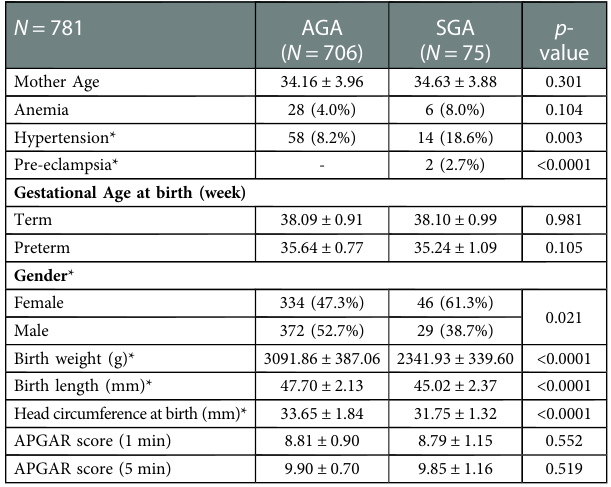
TABLE 2 Patient characteristics from May 2020 – Apr